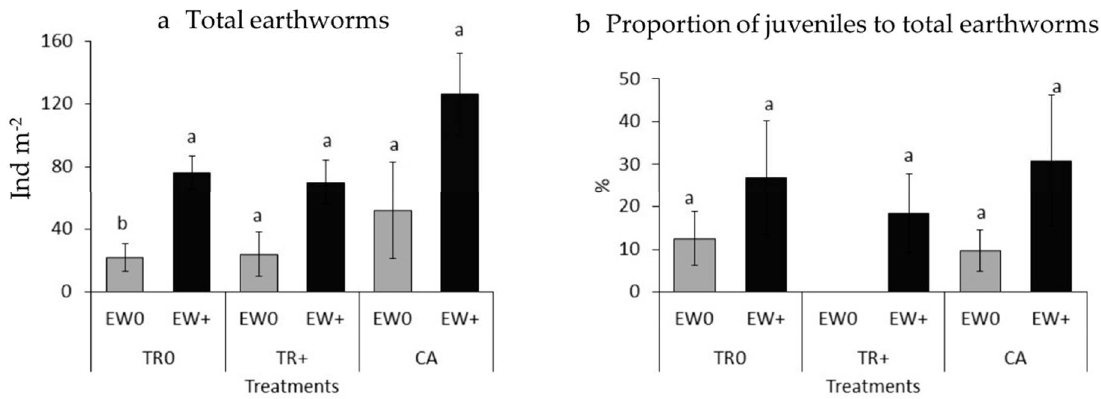
Figure 2. Earthworm density (ind m − 2 ) at the end of the rainy period of the 4th cropping season according to treatments (earthworm inoculation, cropping system) ( a ) and proportion of juveniles to total earthworms ( b ). Error bars indicate standard errors. Letters indicate significant differences between EW0 and EW+ for different cropping systems according to Student t-test. See Figure 1 for legend.